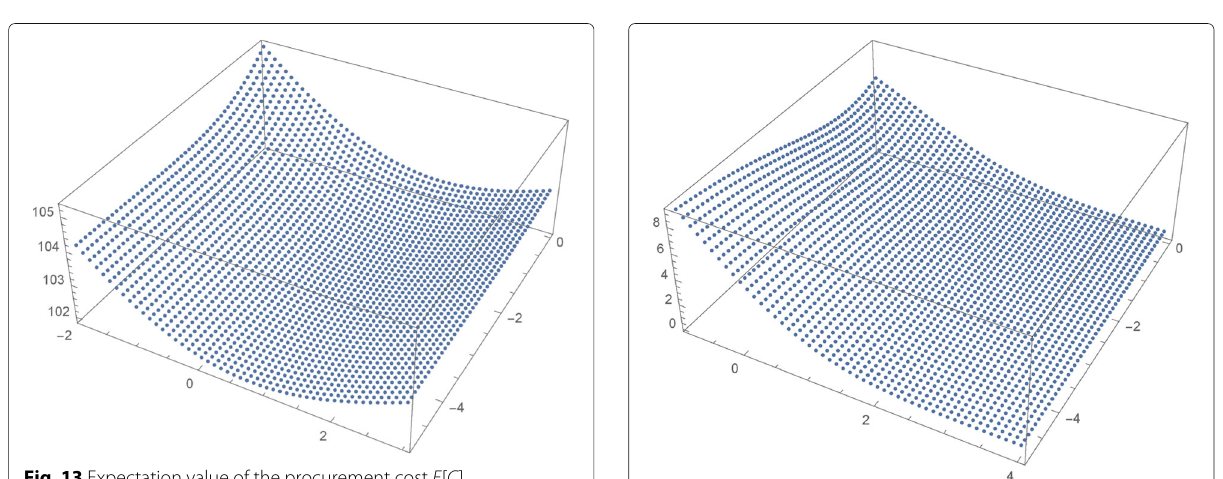
Fig. 13 Expectation value of the procurement cost E [ C ]